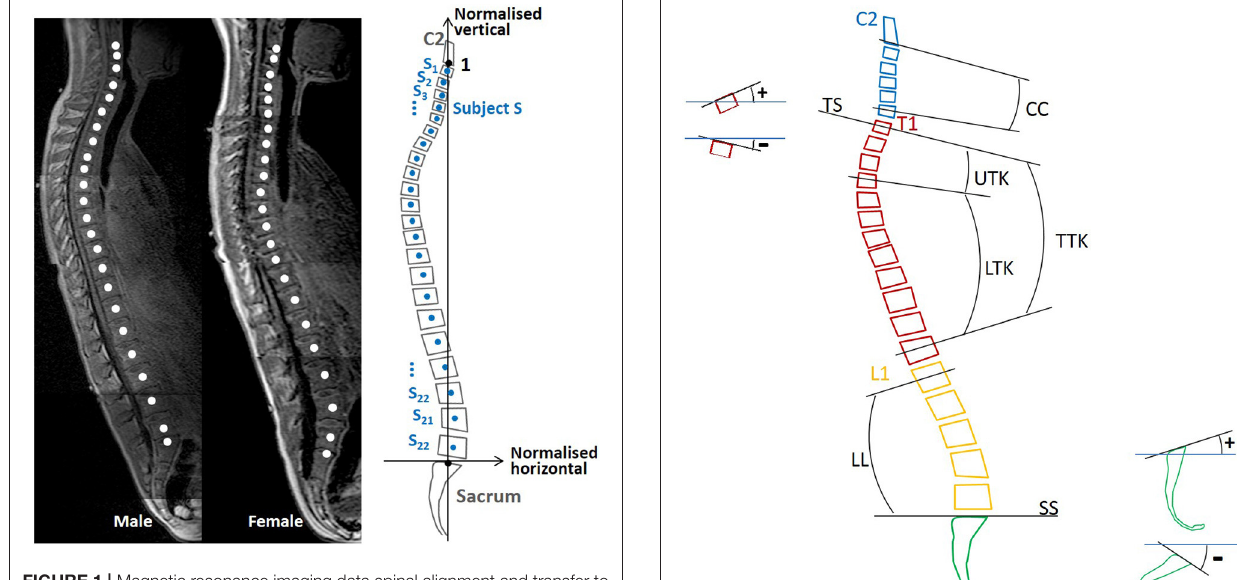
FIGURE 1 | Magnetic resonance imaging data spinal alignment and transfer to a normalized coordinate system.